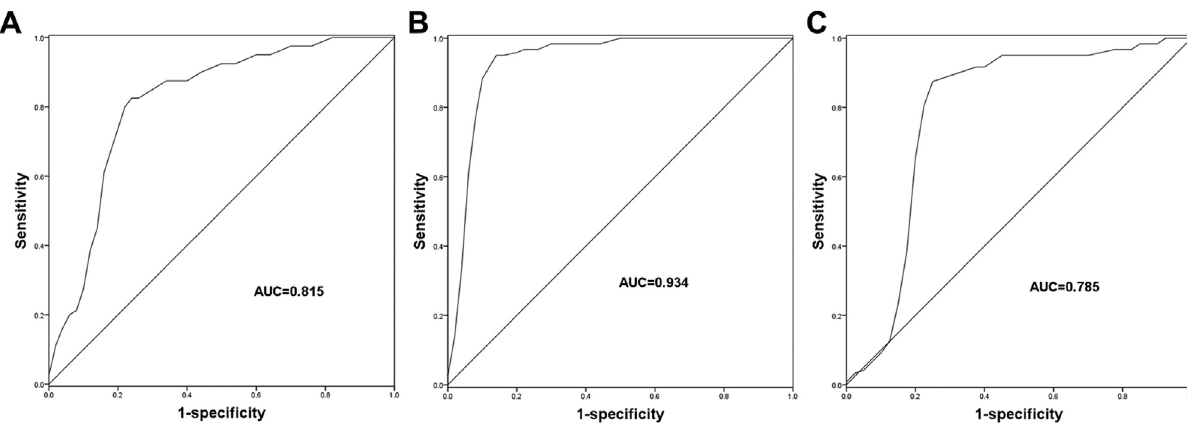
Figure 2 - ROC curves based on the serum expression of miR-145. A. miR-145 could be used to distinguish LTB patients from the healthy controls with an AUC of 0.815. B. miR-145 had high diagnostic value for the differentiation between ATB patients and healthy controls with an AUC of 0.934. C. miR-145hadthediagnosticpotentialtoscreenATBcasesfromtheLTBcaseswithanAUCvalueof0.785.HC,healthycontrol;LTB,latenttuberculosis; ATB, active tuberculosis; AUC, area under the ROC curve.